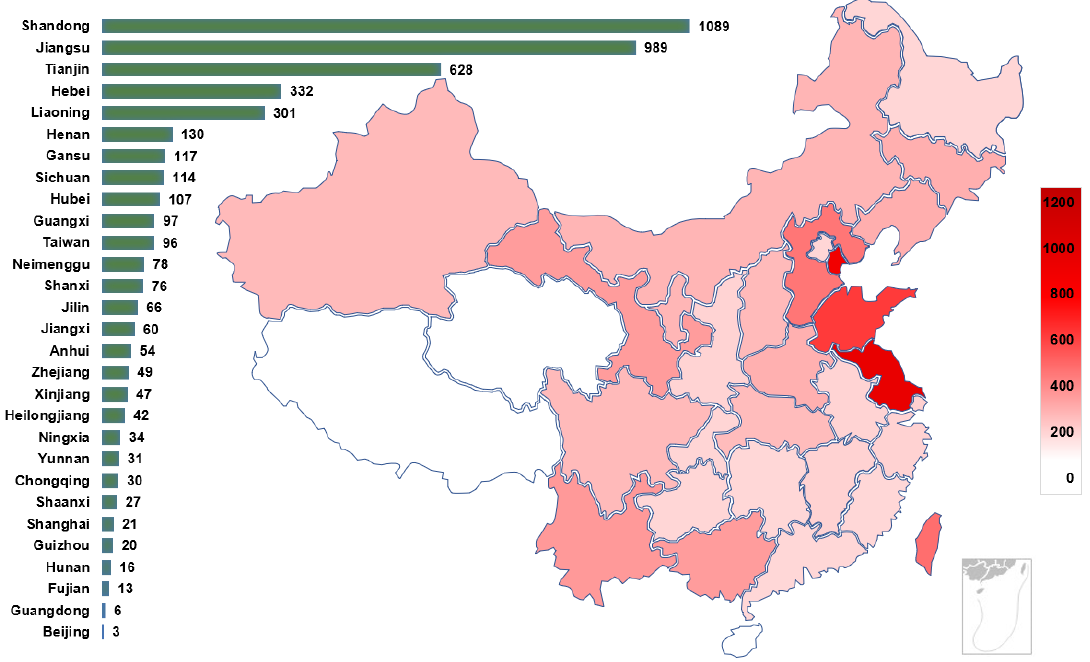
Figure 2. Regional distribution of LAHCA in China. Note: Beijing, Tianjin, Shanghai, and Chongqing are municipalities.